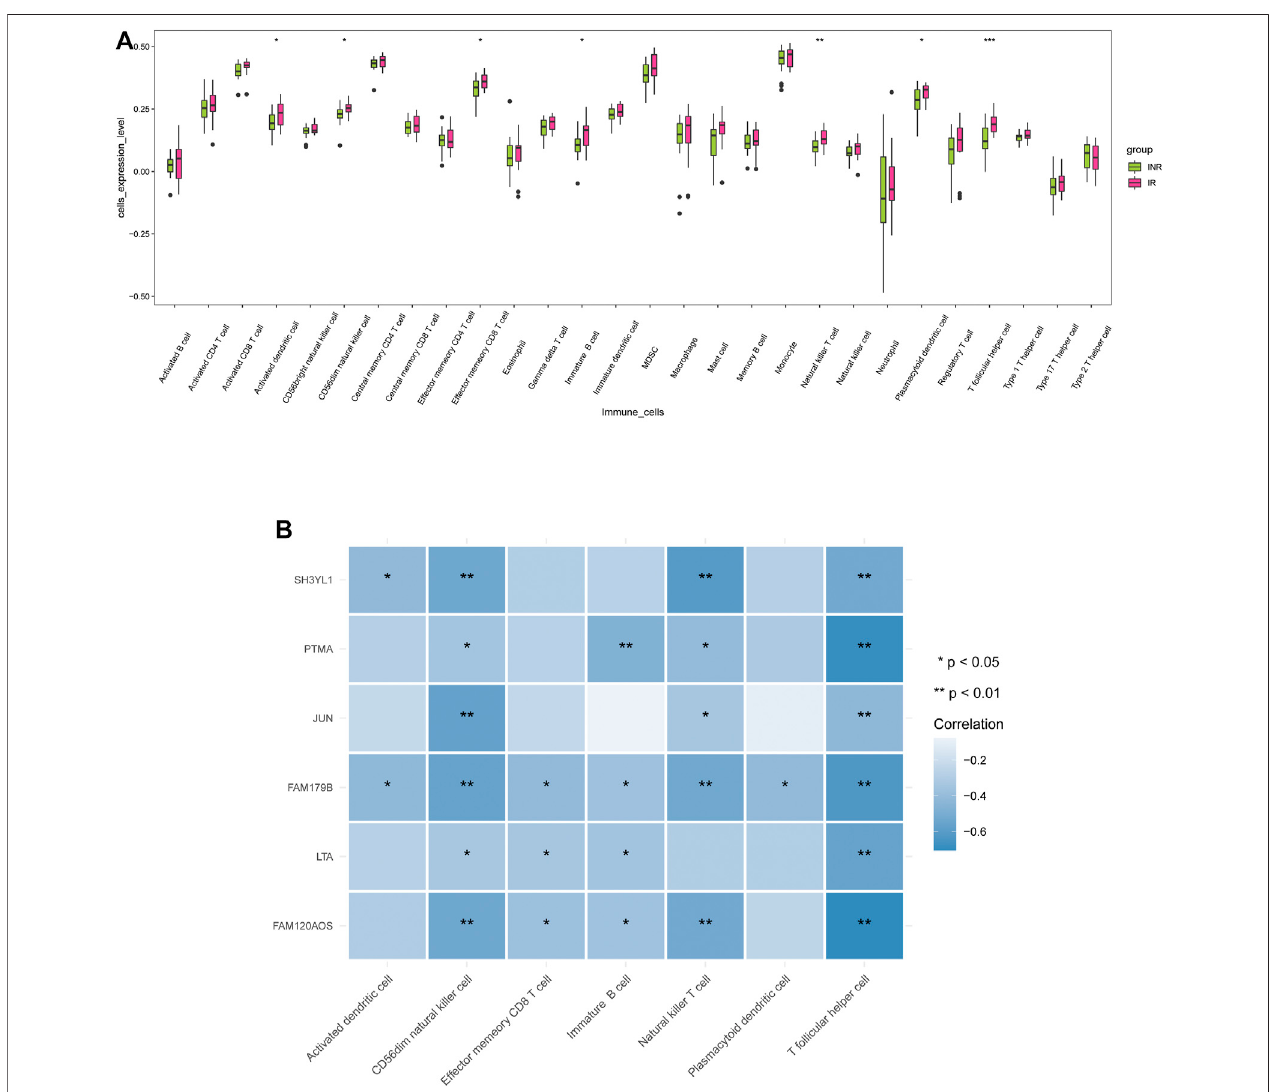
FIGURE 5 | Correlations between diagnostic markers and immune cells. (A) The discrepancy of enrichment scores for 28 immune cells between the INRs and IRs samples. (B) The correlation heatmap of 6 diagnostic markers and 7 differential immune cells.